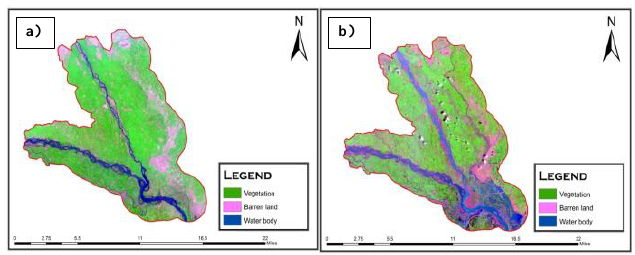
Figure 2: (a) Pre-flood Landsat-7 image of July 22, 2010 (b) Post-flood Landsat-7 image of August 04, 2010, clearly shows flood event.